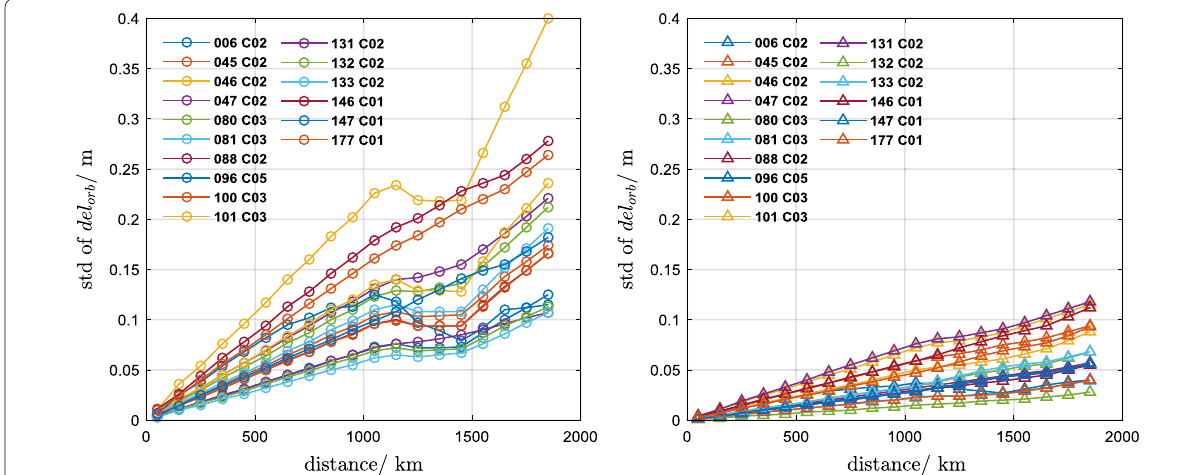
Fig. 7 STDs of del orb in the test area vary with distance from the center of the zone, before (left) and after (right) the fluctuation